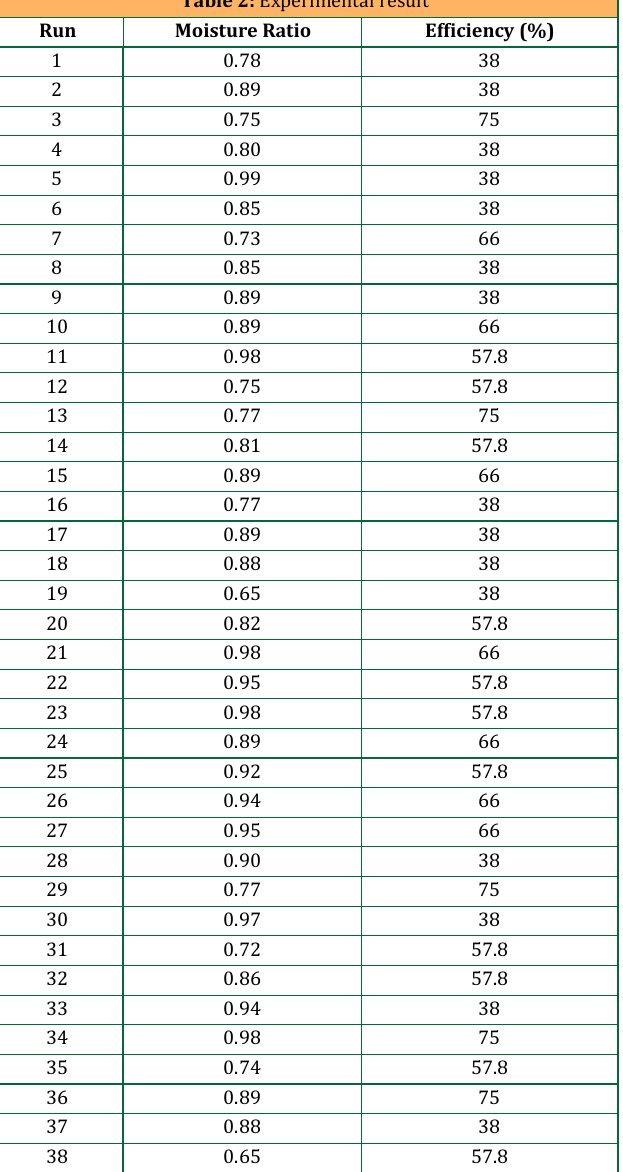
Table 2: Experimental result